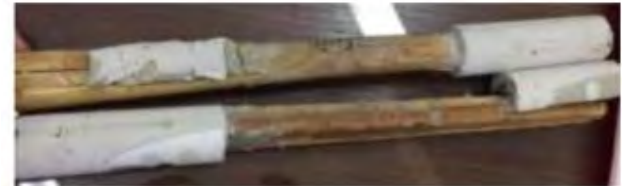
Figure 20. Zoom in on the longitudinal cracks under the Epoxy (Author’s own,